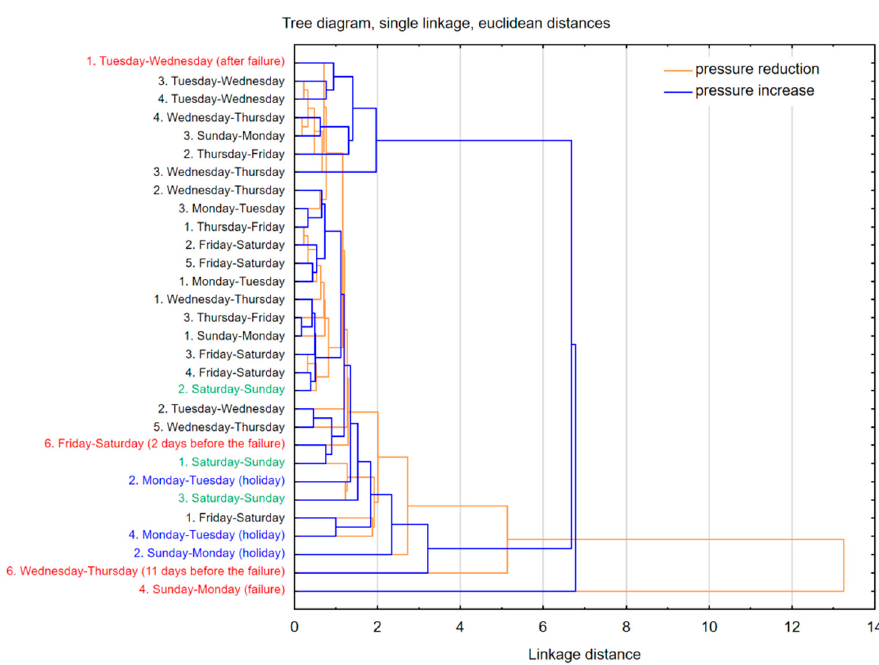
Figure 4. Dendrograms obtained using cluster analysis of exponents α k − n during pressure reduction and increase.